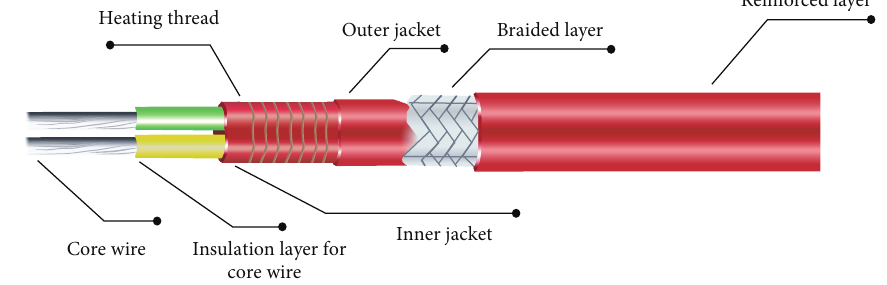
Figure 3: Heating cable